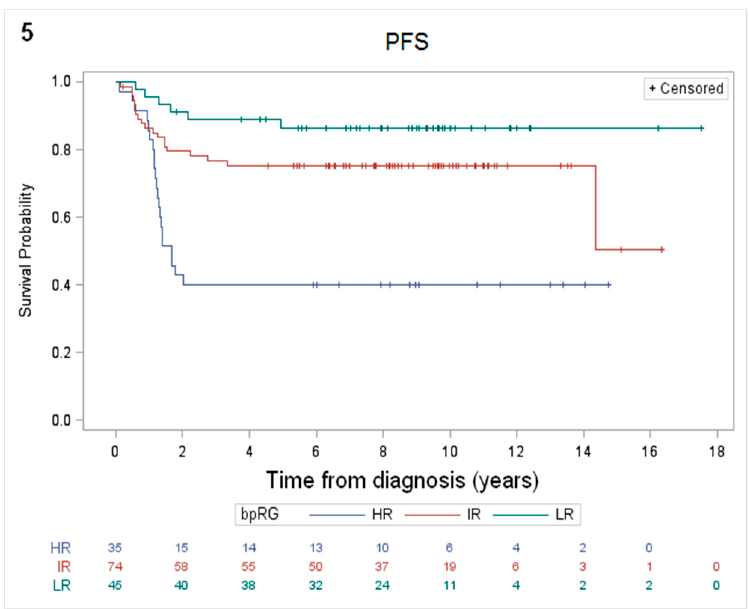
Figure 5. The 10-year PFS was 40% (SE ± 8%), 75% (SE ± 5%) and 86% (SE ± 5%) for bpHR ( n = 35), bpIR ( n = 74) and bpLR ( n = 45), respectively ( p < 0.0001).